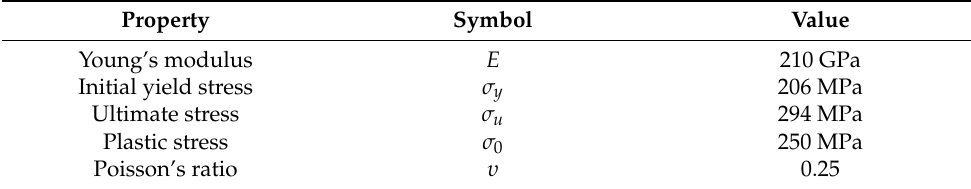
Table 2. Material properties of steel Q235